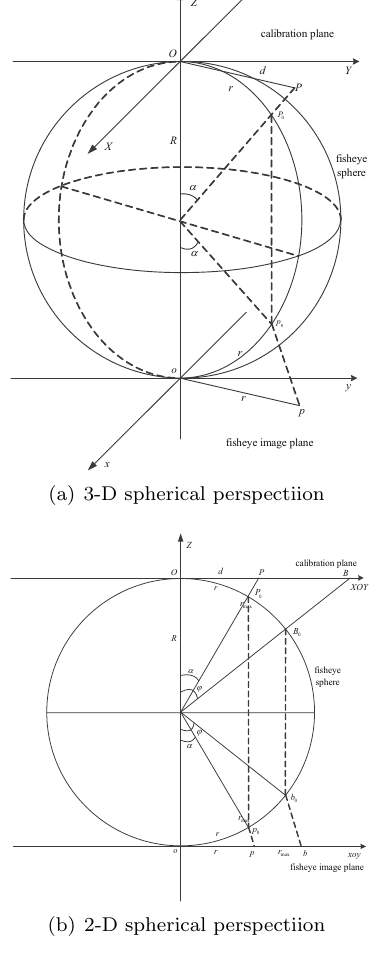
Figure 16: Fisheye